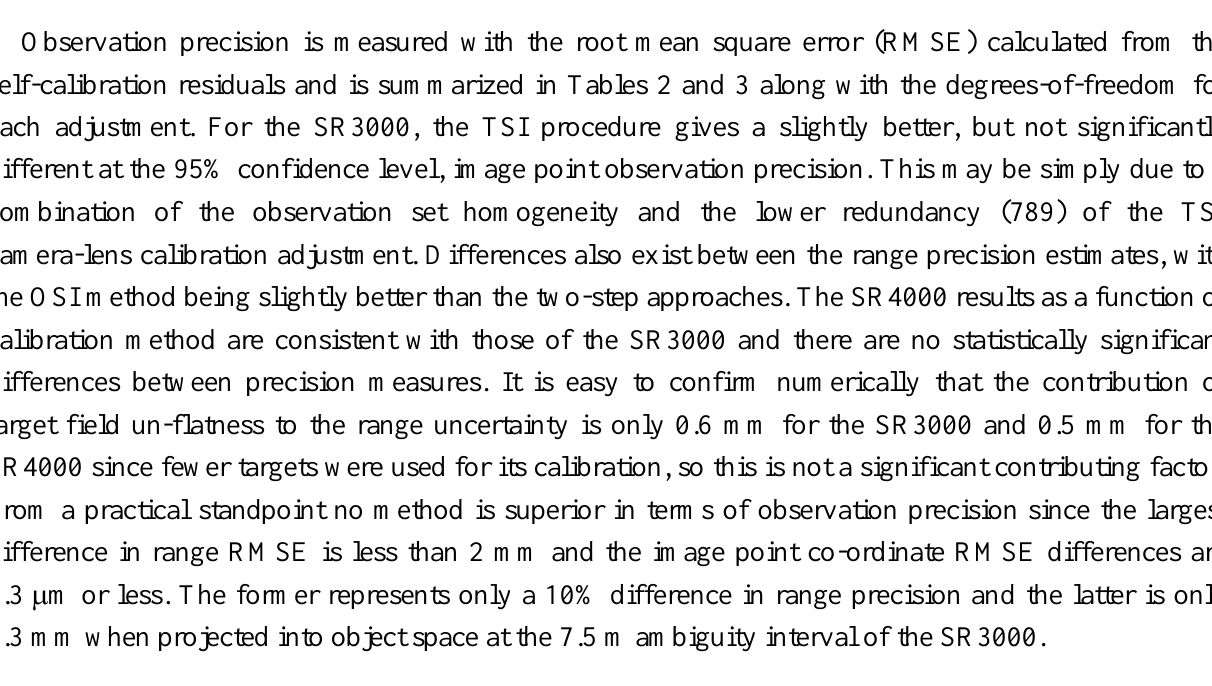
Table 2. SR3000 self-calibration precision statistical summary.